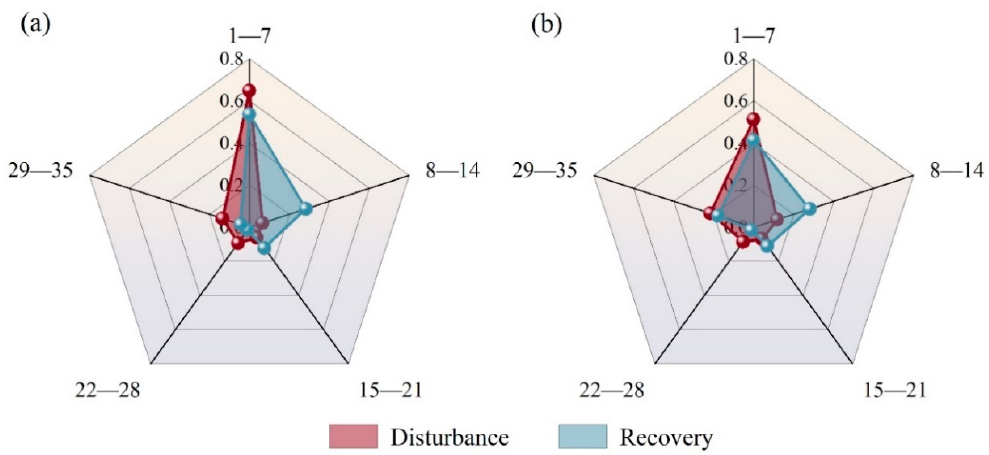
Figure 7. Percentage of different durations. ( a ) the western mine; ( b ) the eastern mine.